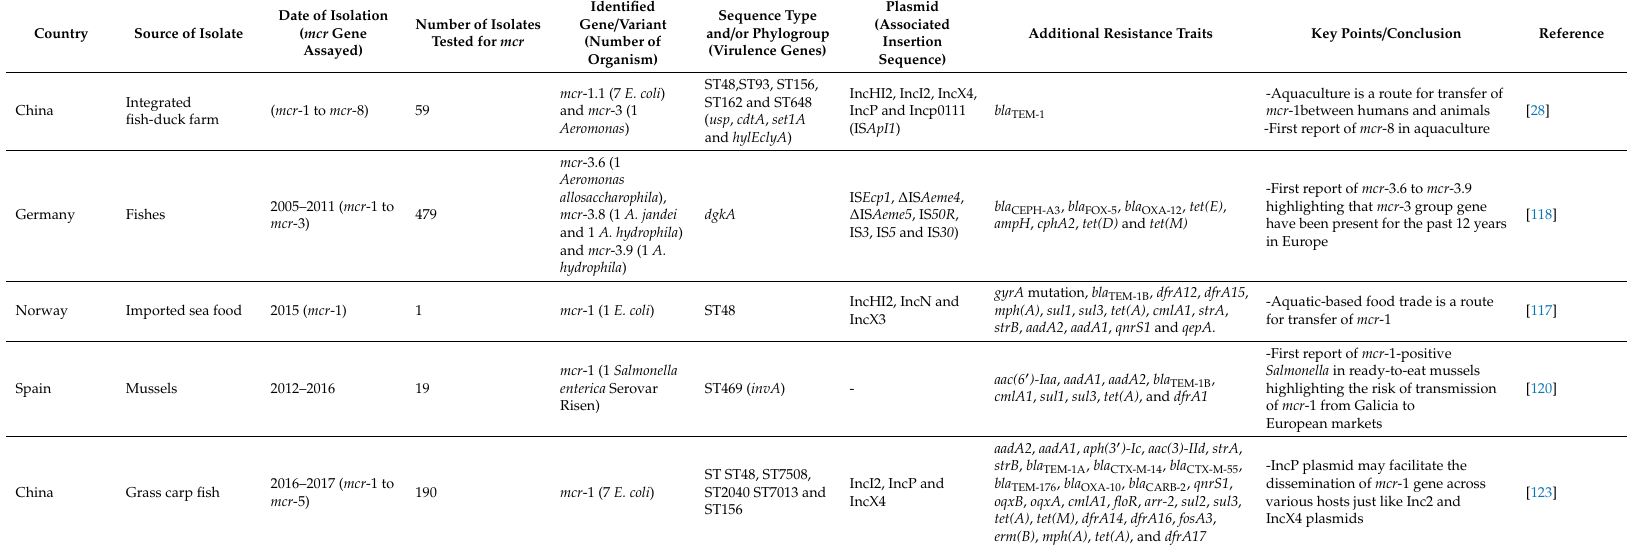
Table 4. Studies reporting plasmid-mediated colistin resistance in aquaculture environment and aquatic-based foods.